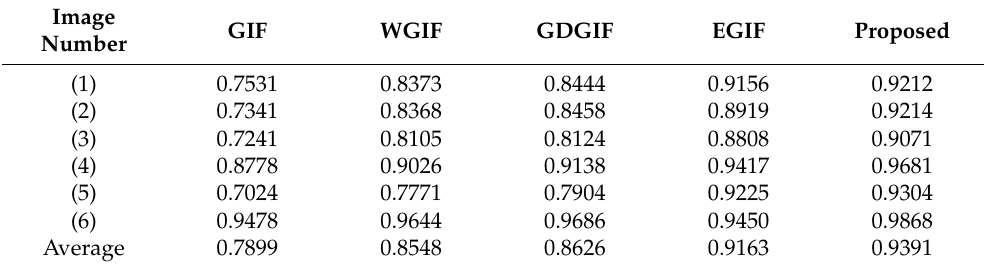
Table 2. SSIM calculation results.